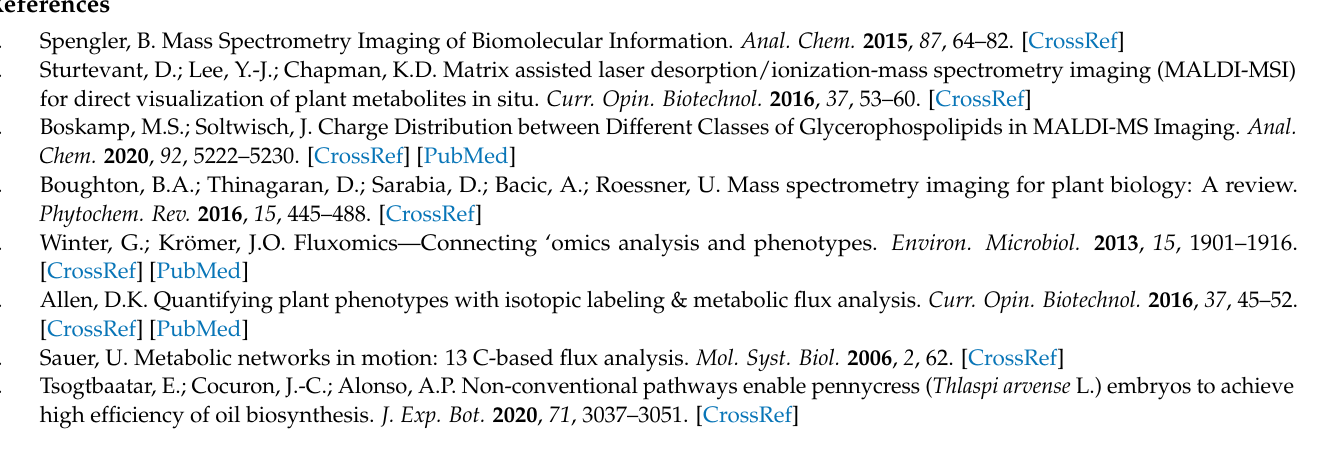
species, Table S2: Calculations for isotopologue distribution and average labeling of fatty acid